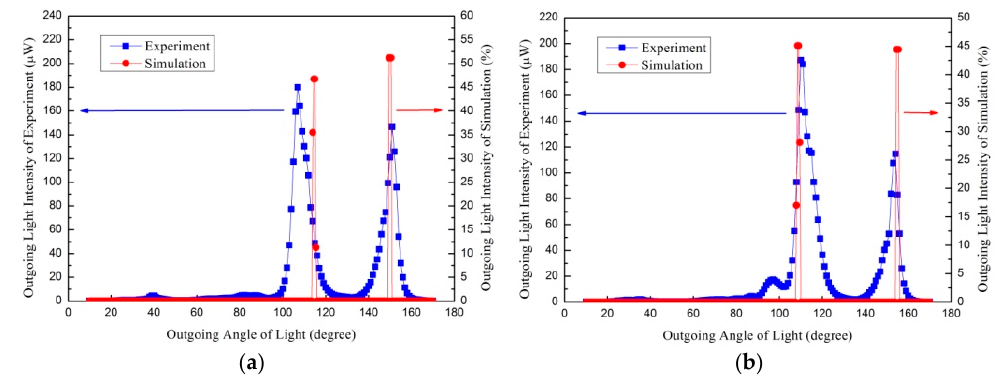
Figure 12. Comparison between the experimental and simulation results at outgoing angles of ( a ) 55° and ( b ) 60°.